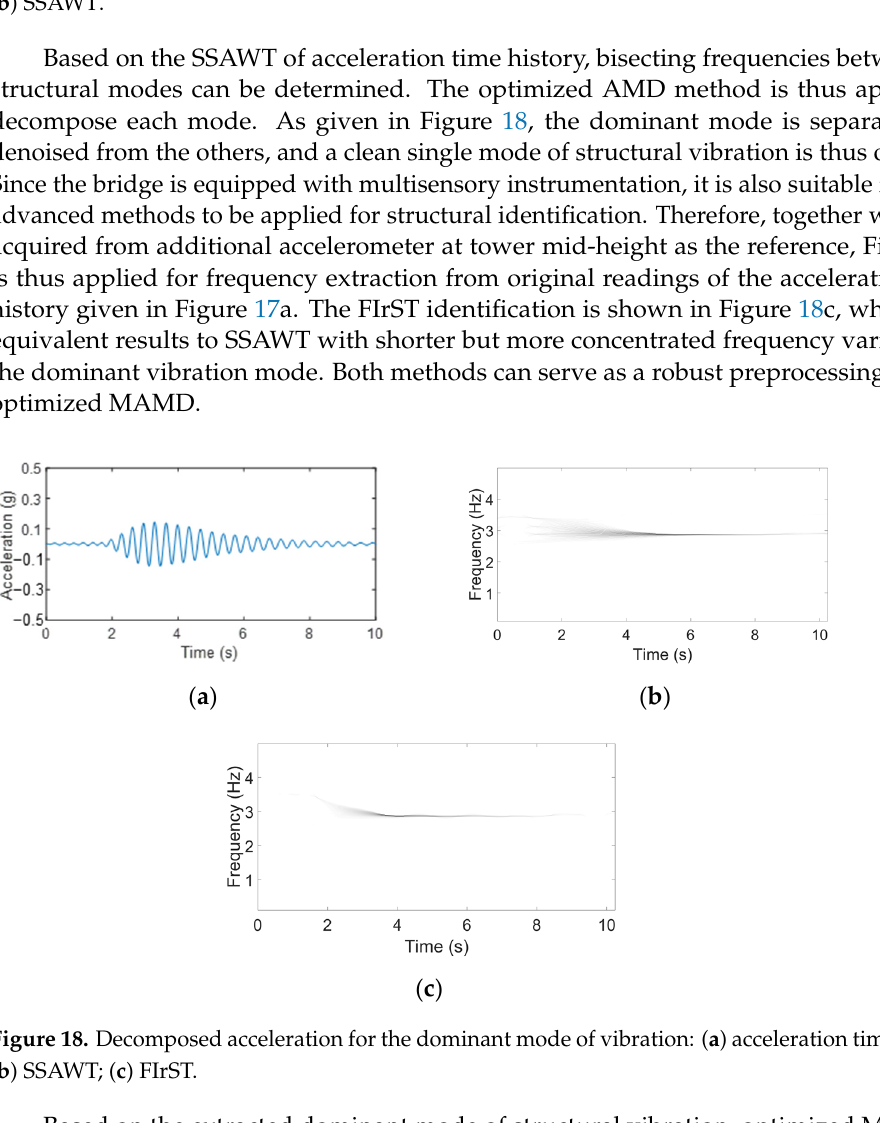
Figure 17. Acceleration at tower top under 0.4 g earthquake input: ( a ) acceleration time history; ( b ) SSAWT.